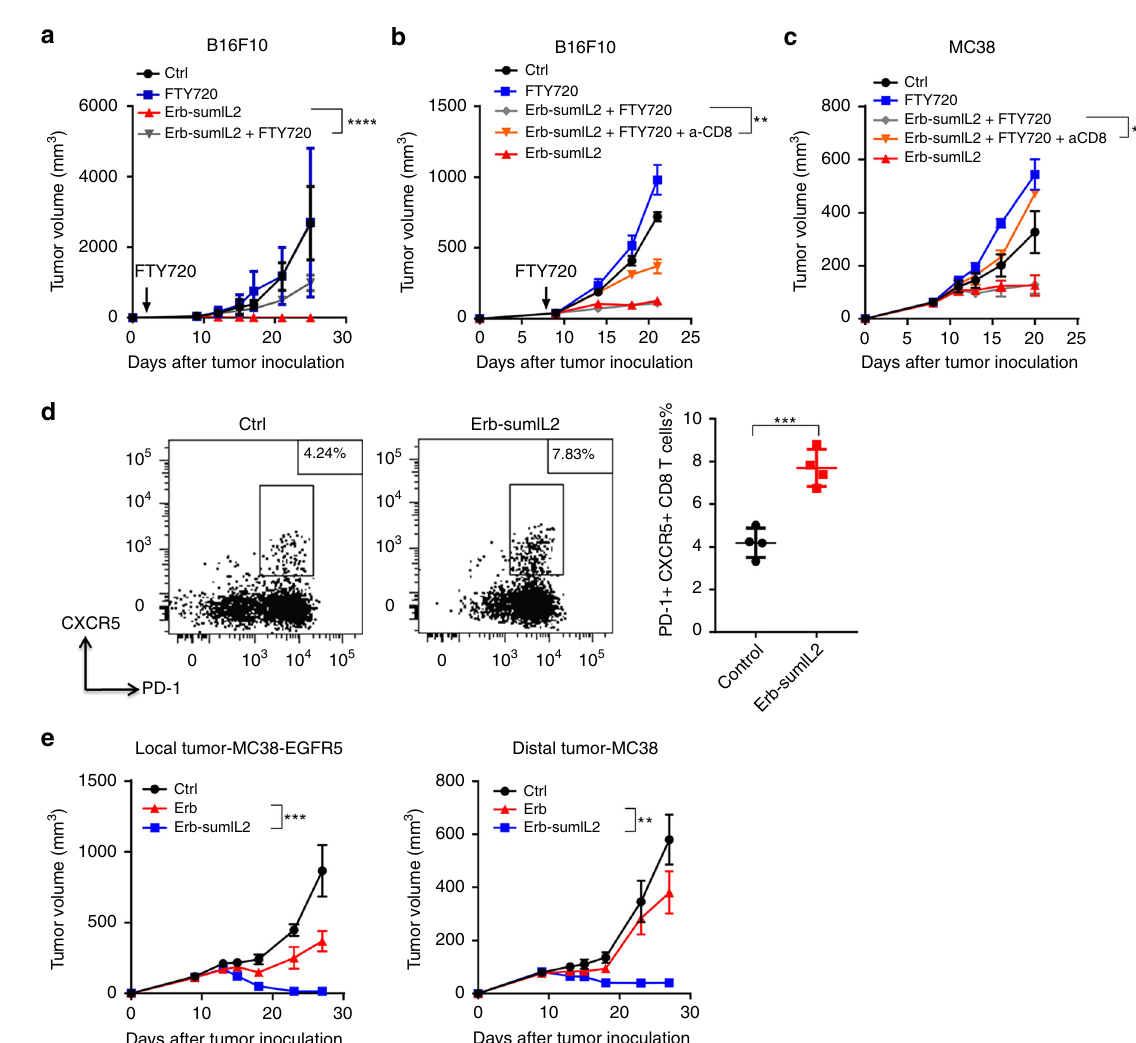
Fig. 4 Pre-existing intratumoral CTLs are suf fi cient and essential for Ab-sumIL2 therapy and activated CTLs can control distal tumors. a WT C57BL/6 mice ( n = 5 group) were injected subcutaneously with 5 × 10 5 of B16F10 cells, and then i.t. treated on days 9, 12, and 15 with PBS or 10 μ g of Erb-sumIL2. For FTY720 blockade, 10 μ g FTY720 was given from day 1 and every other day thereafter for 4 times. b WT C57BL/6 mice ( n = 5 group) were injected subcutaneously with 5 × 10 5 of B16F10 cells and i.t. treated with 10 μ g of Erb-sumIL2 on days 9, 12, and 15. FTY720 blockade and CD8 T cell depletion started on day 8 posttumor inoculation. c WT C57BL/6 mice ( n = 5 group) were injected subcutaneously with 5 × 10 5 MC38 cells and i.t. treated with 10 μ g Erb-sumIL2 on days 8, 11, and 13. FTY720 blockade and CD8 depletion were performed starting from day 7 of tumor inoculation. d WT C57BL/6 mice ( n = 3 – 5 group) were injected subcutaneously with 5 × 10 5 of B16F10 cells and i.t. treated with 10 μ g of Erb-sumIL2 on day 9. Tumor tissues were collected on day 12 and the frequency of PD-1 + CXCR5 + CD8 + T cells was detected by fl ow cytometry. e WT C57BL/6 mice ( n = 5 group) were injected subcutaneously with 5 × 10 5 MC38 (left fl ank) and MC38-EGFR5 (right fl ank) cells. MC38-EGFR5 tumor was i.t. treated with 10 μ g Cetuximab (Erb) or 10 μ g Erb-sumIL2 on days 9, 12, and 15. The volume of both tumors was measured twice a week. Two way ANOVA tests were used to analyze the